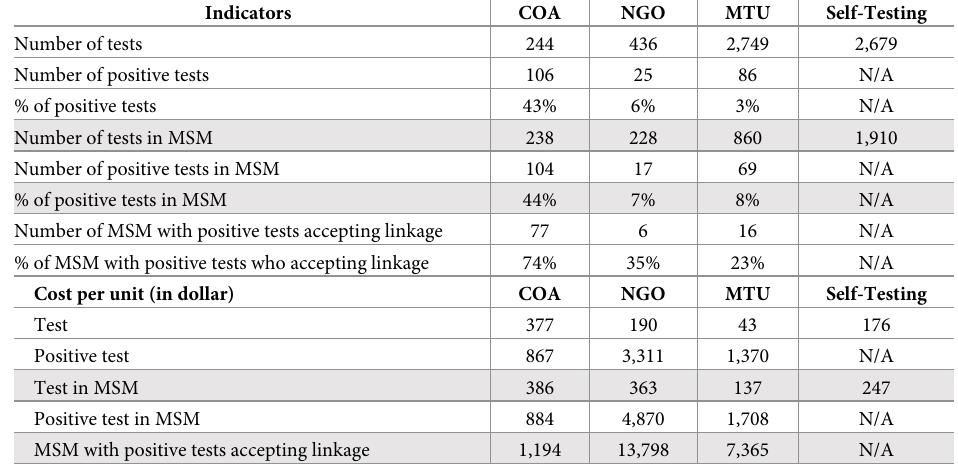
Table 4. Results of the cost-analysis according to the number and cost of the tests according to the AHA´s strate- gies—Curitiba/PR/Brazil—03/01/2015 to 02/28/2016. Indicators